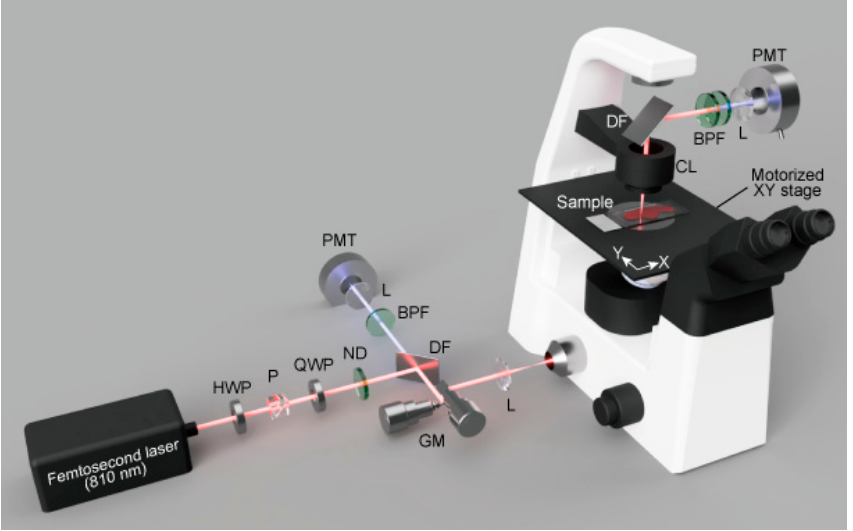
Figure 5. A home-built laser-scanning SHG microscope with a motorised XY stage. BPF, band-pass filter; CL, condenser lens; DF, dichroic filter; GM, galvanometric mirror; HWP, half-waveplate; L, lens; ND, variable neutral density filter; P, polariser; PMT, photon-counting photomultiplier tube; QWP, quarter